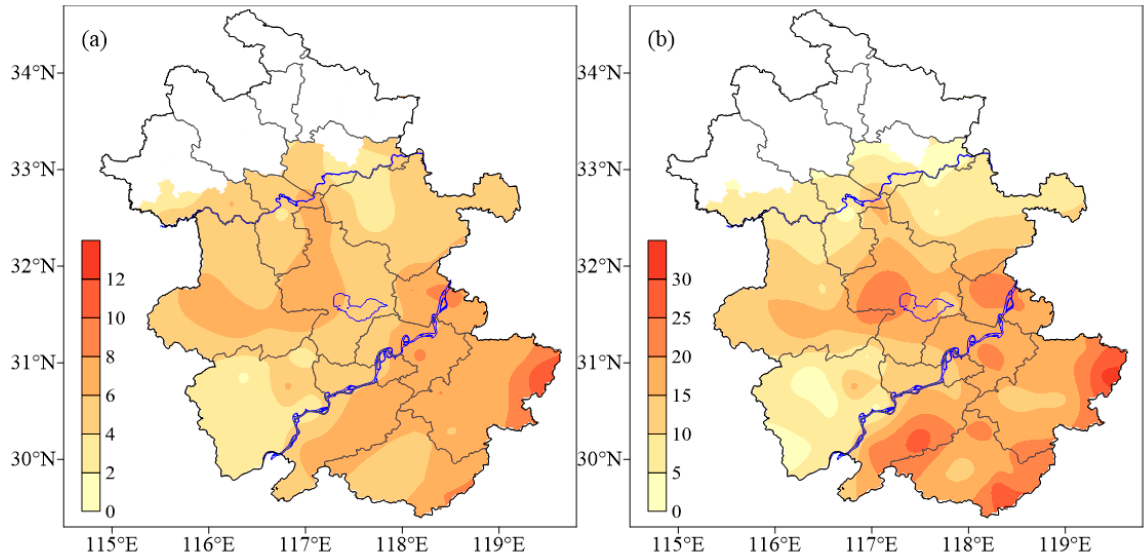
Figure 5. Spatial distribution of variation trends of HSWI ( a ) and payout ( b ) due to rice heat damage in the area south of the Huai River in Anhui Province from 1987 to 2018.